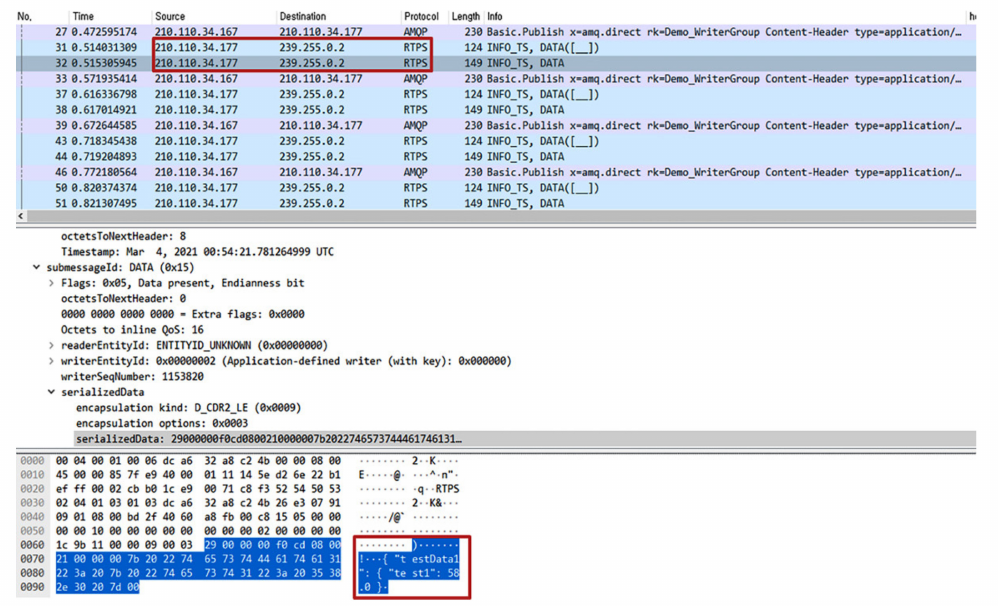
Figure 15. Monitoring screen between the DDS gateway and OPC UA subscriber